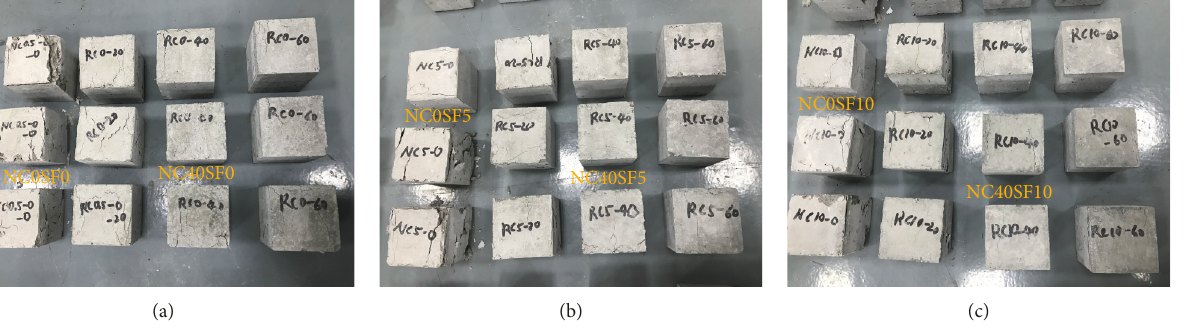
Figure 6: Typical compression failure.